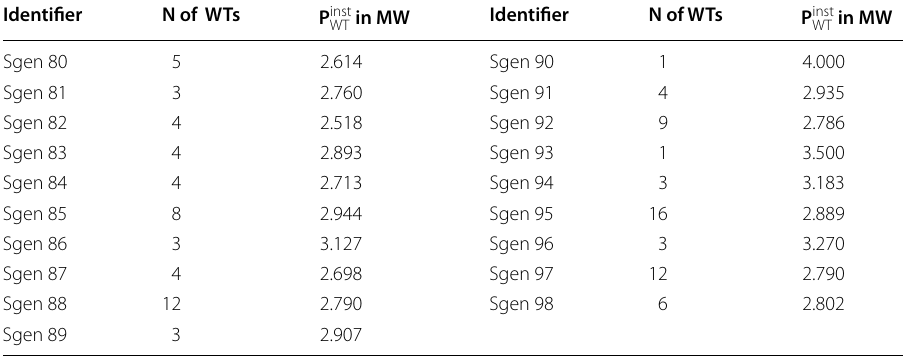
Table 2 Assumed number of individual WTs for the wind farms of the SimBench HV grid and resulting installed power of each